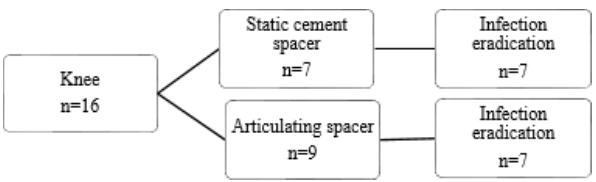
Figure 4. Flow diagram of treatment strategy and infection eradi- cation for patients treated for PJI of the knee. Table 2. Microbiology findings and eradication rate according to causative